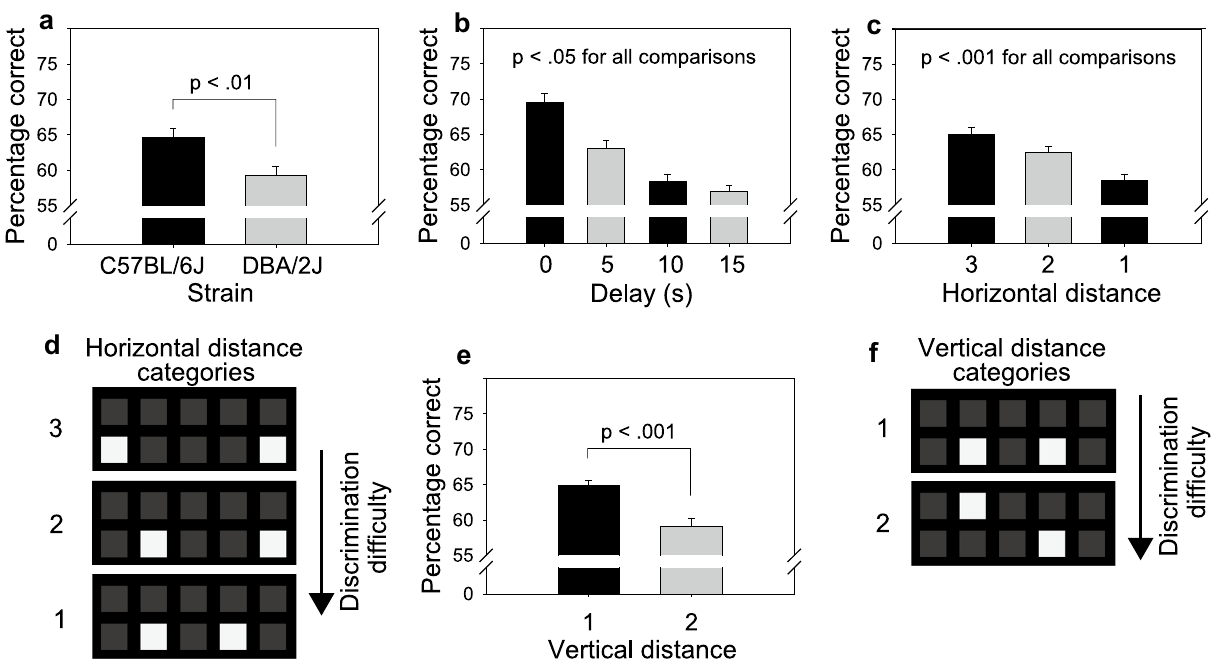
Figure 2. TUNL performance was significantly influenced by strain, delay, horizontal distance, and vertical distance in C57BL/6J and DBA/2J mice. ( a ) TUNL performance of C57BL/6J mice was significantly better than performance of DBA/2J mice. (b) Increasing the delay between the sample phase and choice phase significantly impaired TUNL performance. (c,d) Increasing the horizontal distance between choice-phase stimuli significantly facilitated TUNL performance. (e,f) In contrast, increasing the vertical distance between choice- phase stimuli significantly impaired TUNL performance. Error bars represent